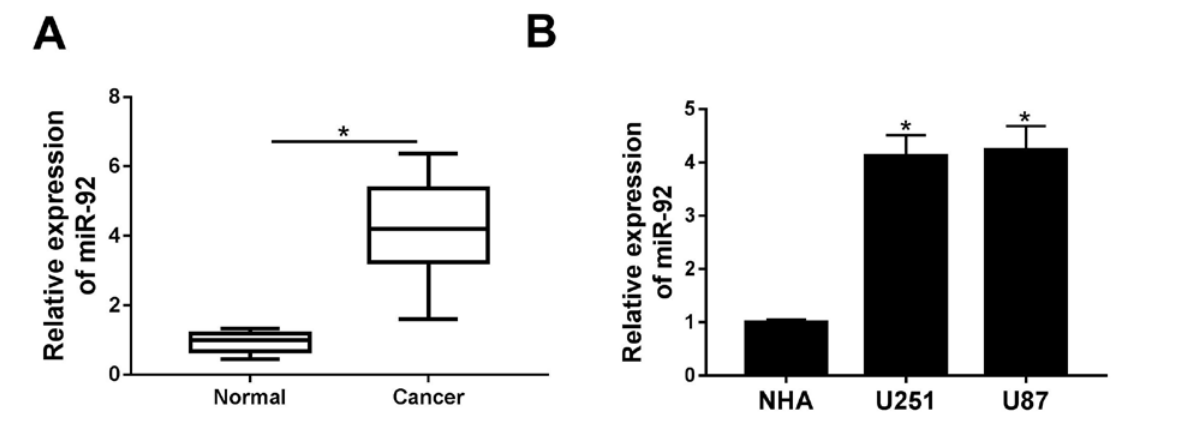
Figure 1: miR-92 was highly expressed in glioma tissues and cell lines. (A) The expression of miR-92 was measured utilizing qRT-PCR assay in 32 pairs of glioma tissues and adjacent normal healthy tissues. (B) qRT-PCR detected miR-92 level in glioma cell lines U251, U87 and normal cell line NHA. *P <